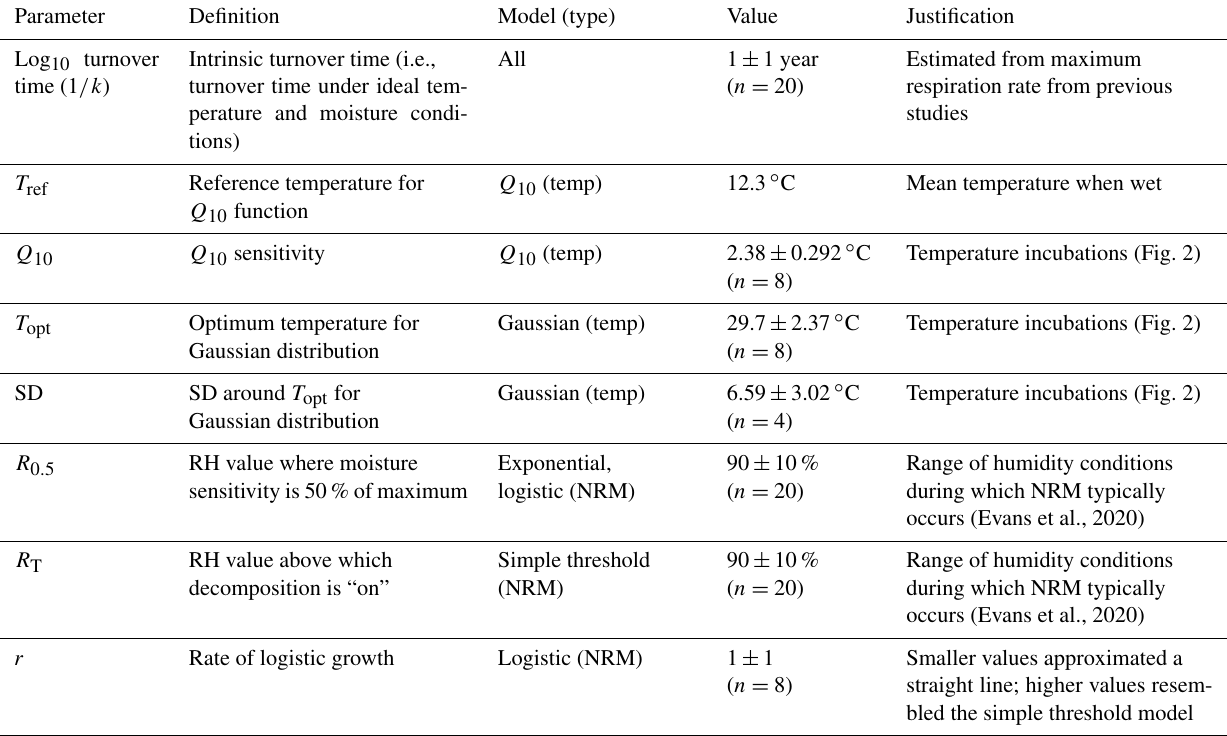
Table 2. Parameter definitions and values used to constrain the second model run to realistic conditions. Values were randomly varied around means and standard deviations shown, with “ n ” denoting the number of iterations used for each parameter ( n = 895230 total model- parameter combinations). For Q 10 , T opt , and SD, models were run with two standard deviations (i.e., twice the value shown